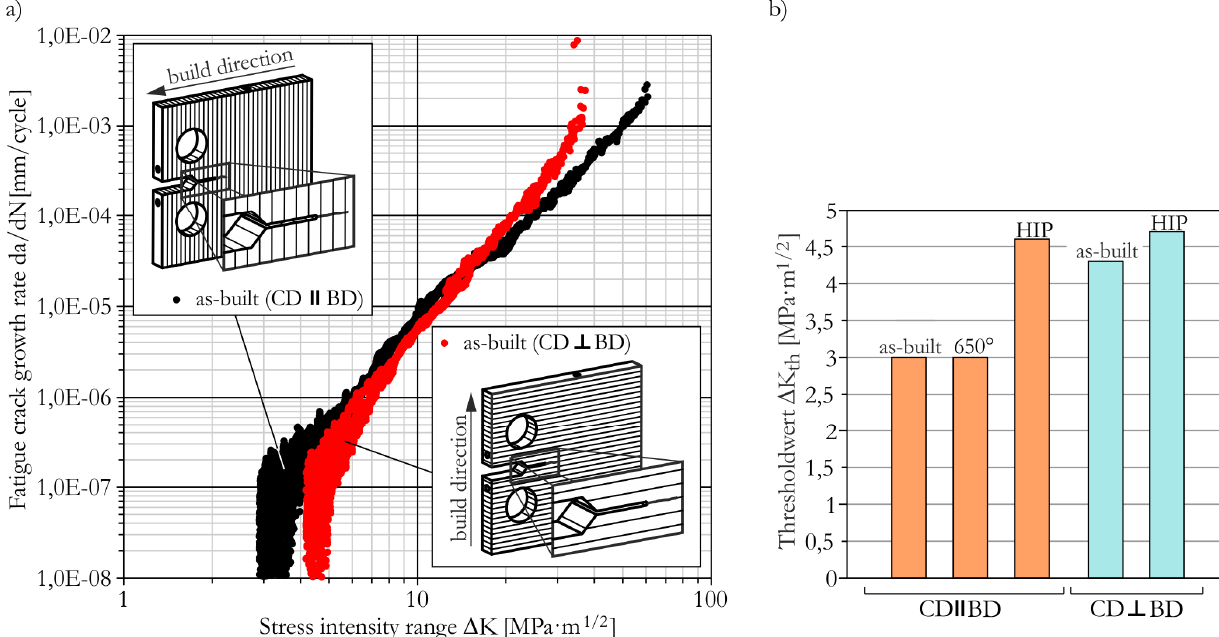
Figure 5: Crack growth curves for the as-built condition and the orientations CD BD and CD BD a) and the threshold